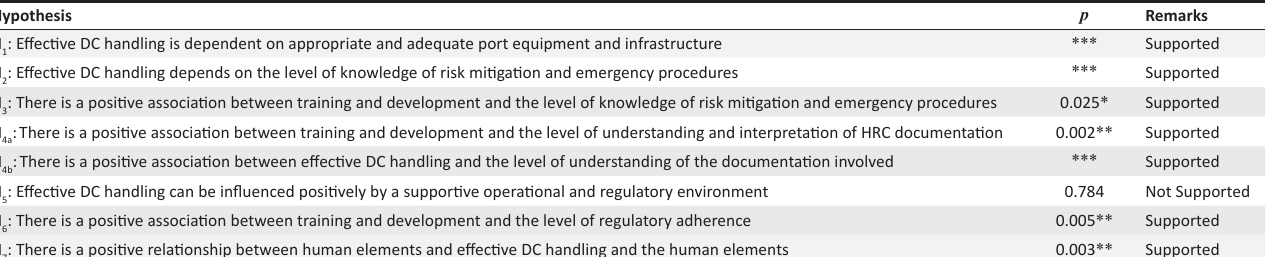
TABLE 5: Hypothesis tests results.